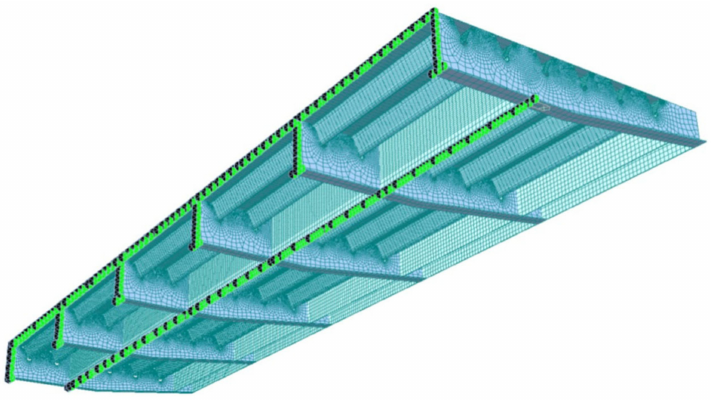
Figure 14. Representation of the shell structural model for nominal stress assessment in the connection details carried out with the MIDAS GEN ® software (version GEN2021 v3.2, MIDAS Information Technology Co.Ltd., Milan,